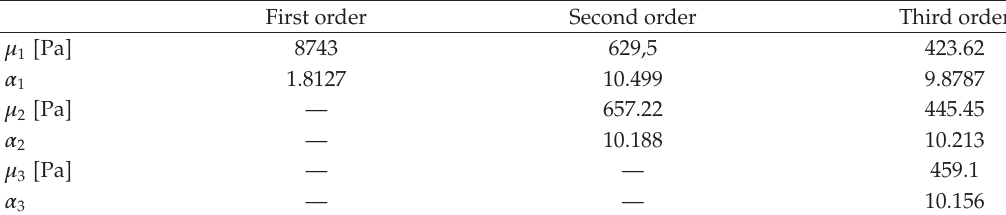
Table 1: Odgen constants.